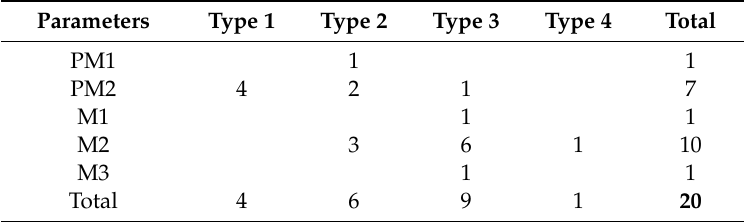
Table 1. Relationship between the tooth type and Shabazian classification.